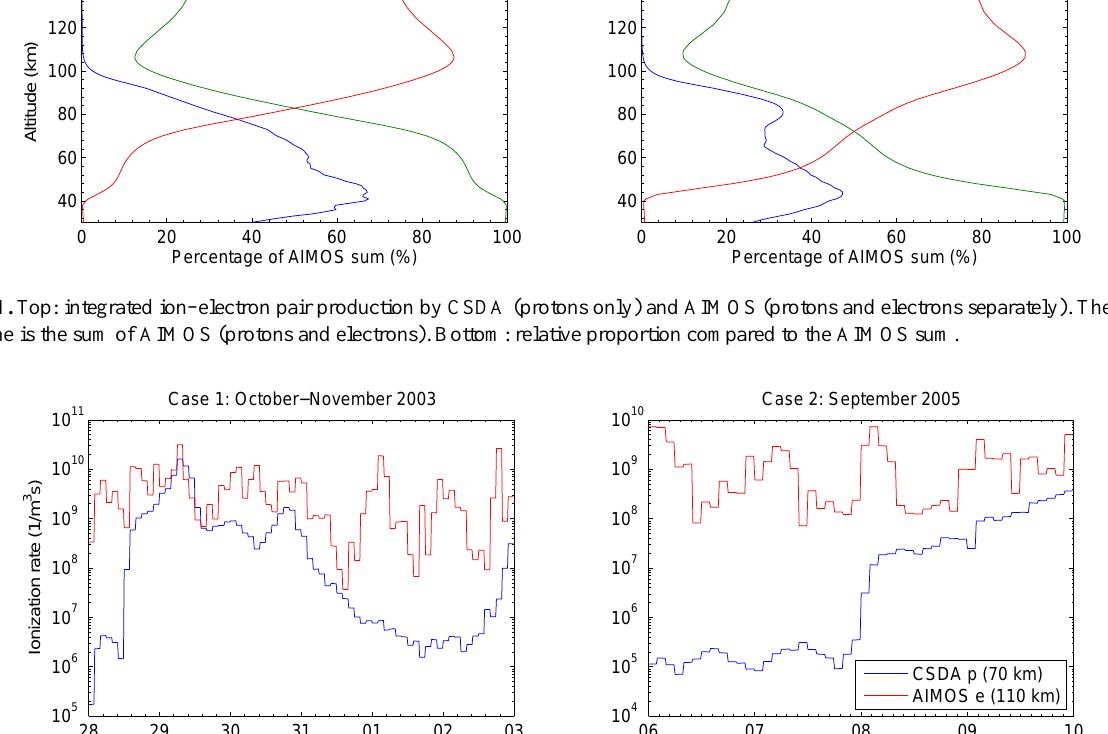
model runs indicate a relatively small contribution from par- ticle precipitation (around 12:00 UT on 7 and 8